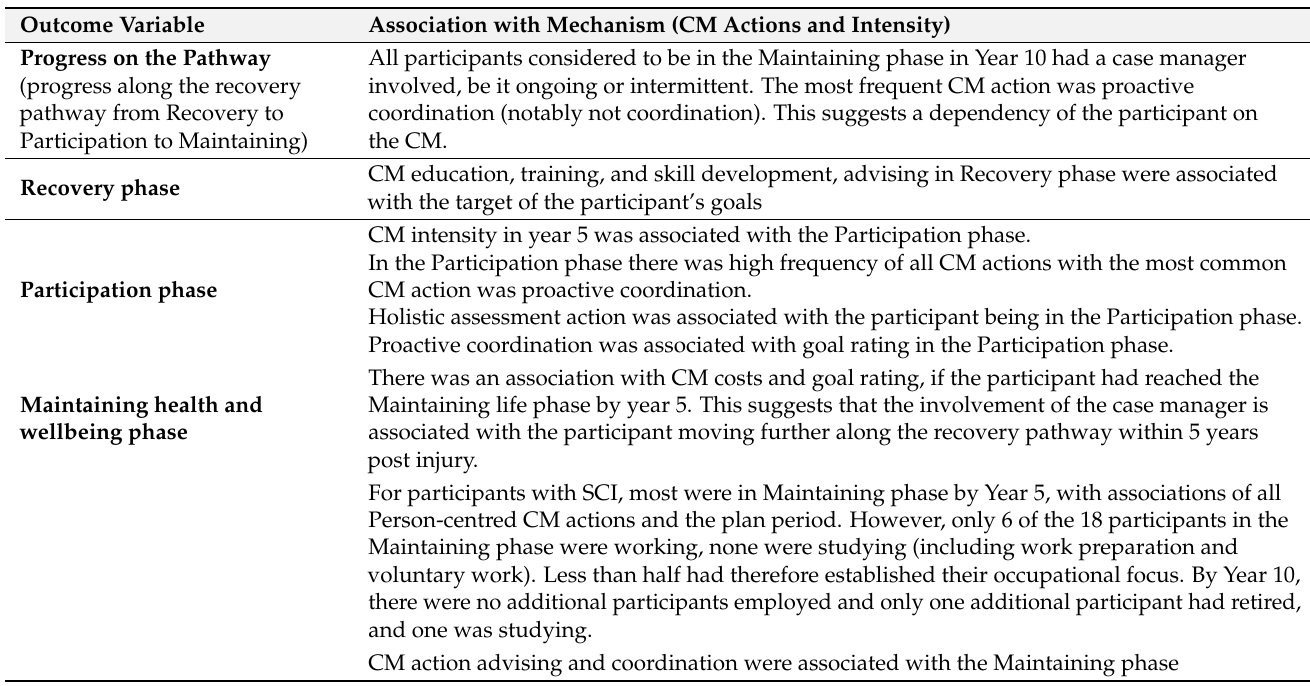
Table 7. SOMNet Results SCI cohort association of outcomes with mechanism variables (weighting >0.8